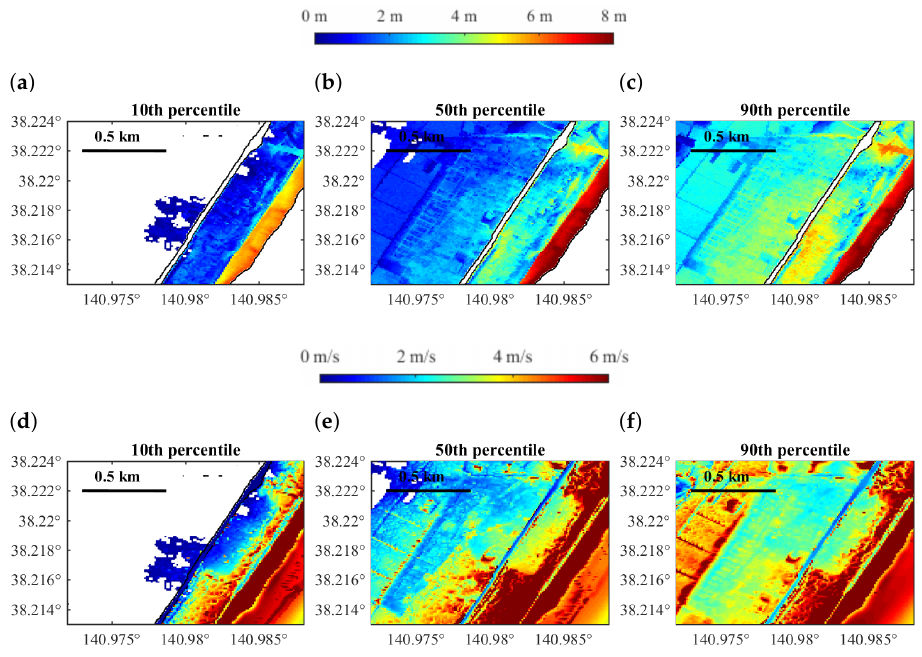
Figure 8. Stochastic tsunami hazard maps for region R2 in Sendai: ( a – c ) inundation depth; and ( d – f ) velocity.